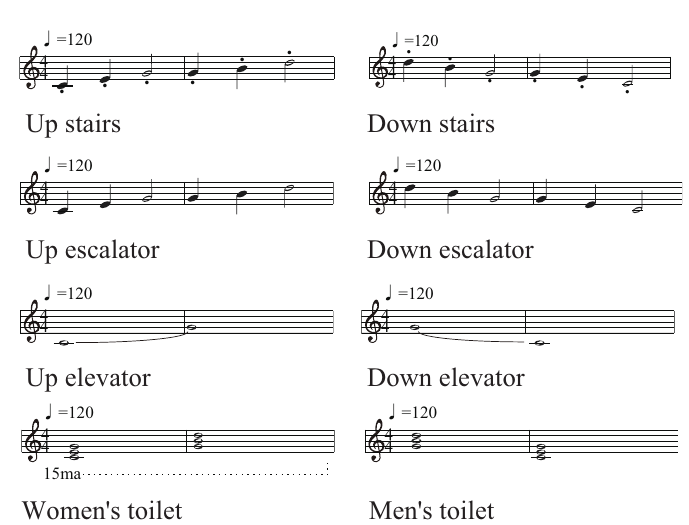
Figure 5. Design indicator of the earcons.